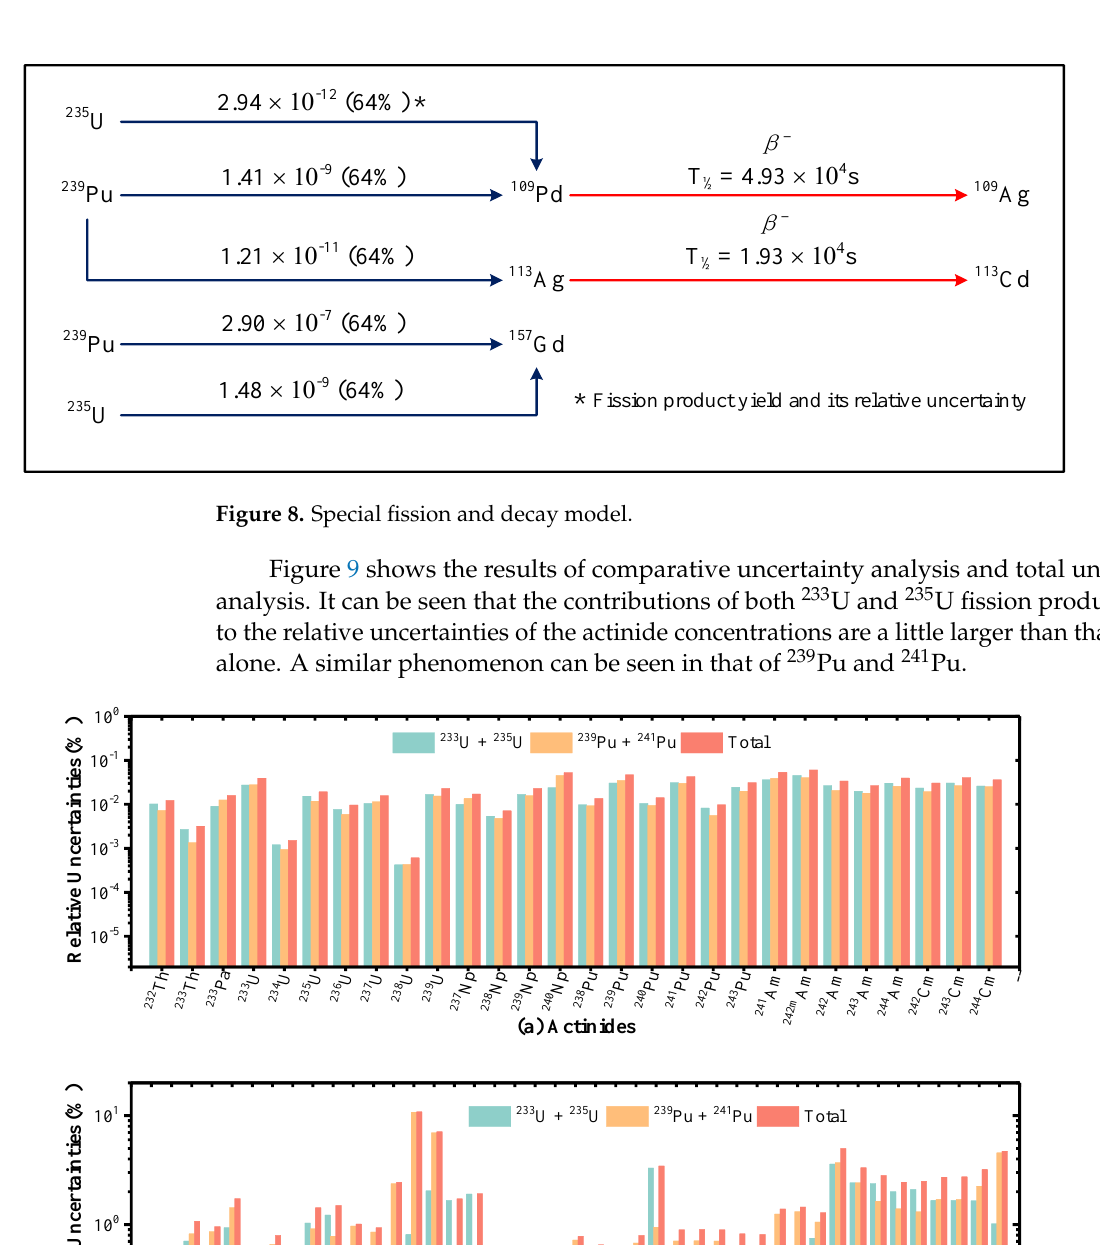
Figure 9. Uncertainties results from comparative and total uncertainty analysis.